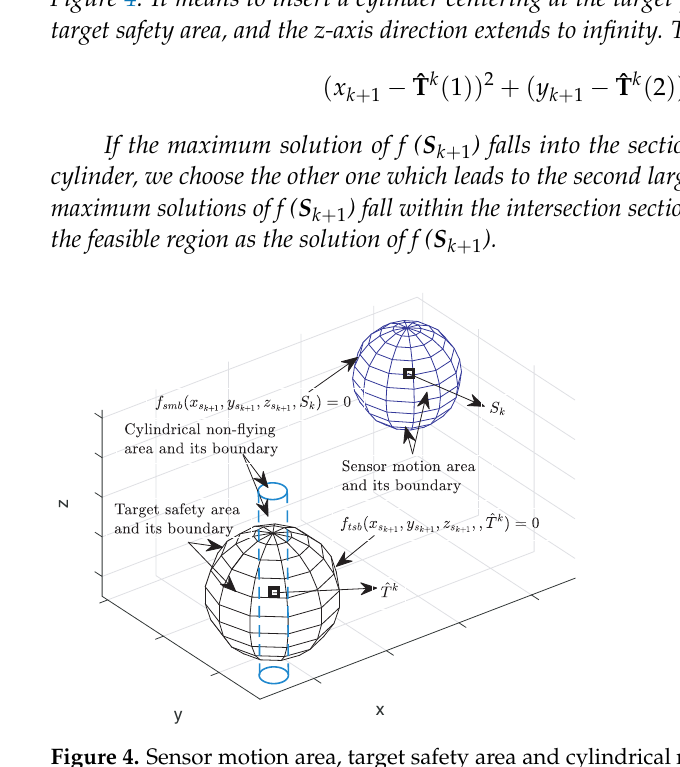
Figure 4. Sensor motion area, target safety area and cylindrical non-flying